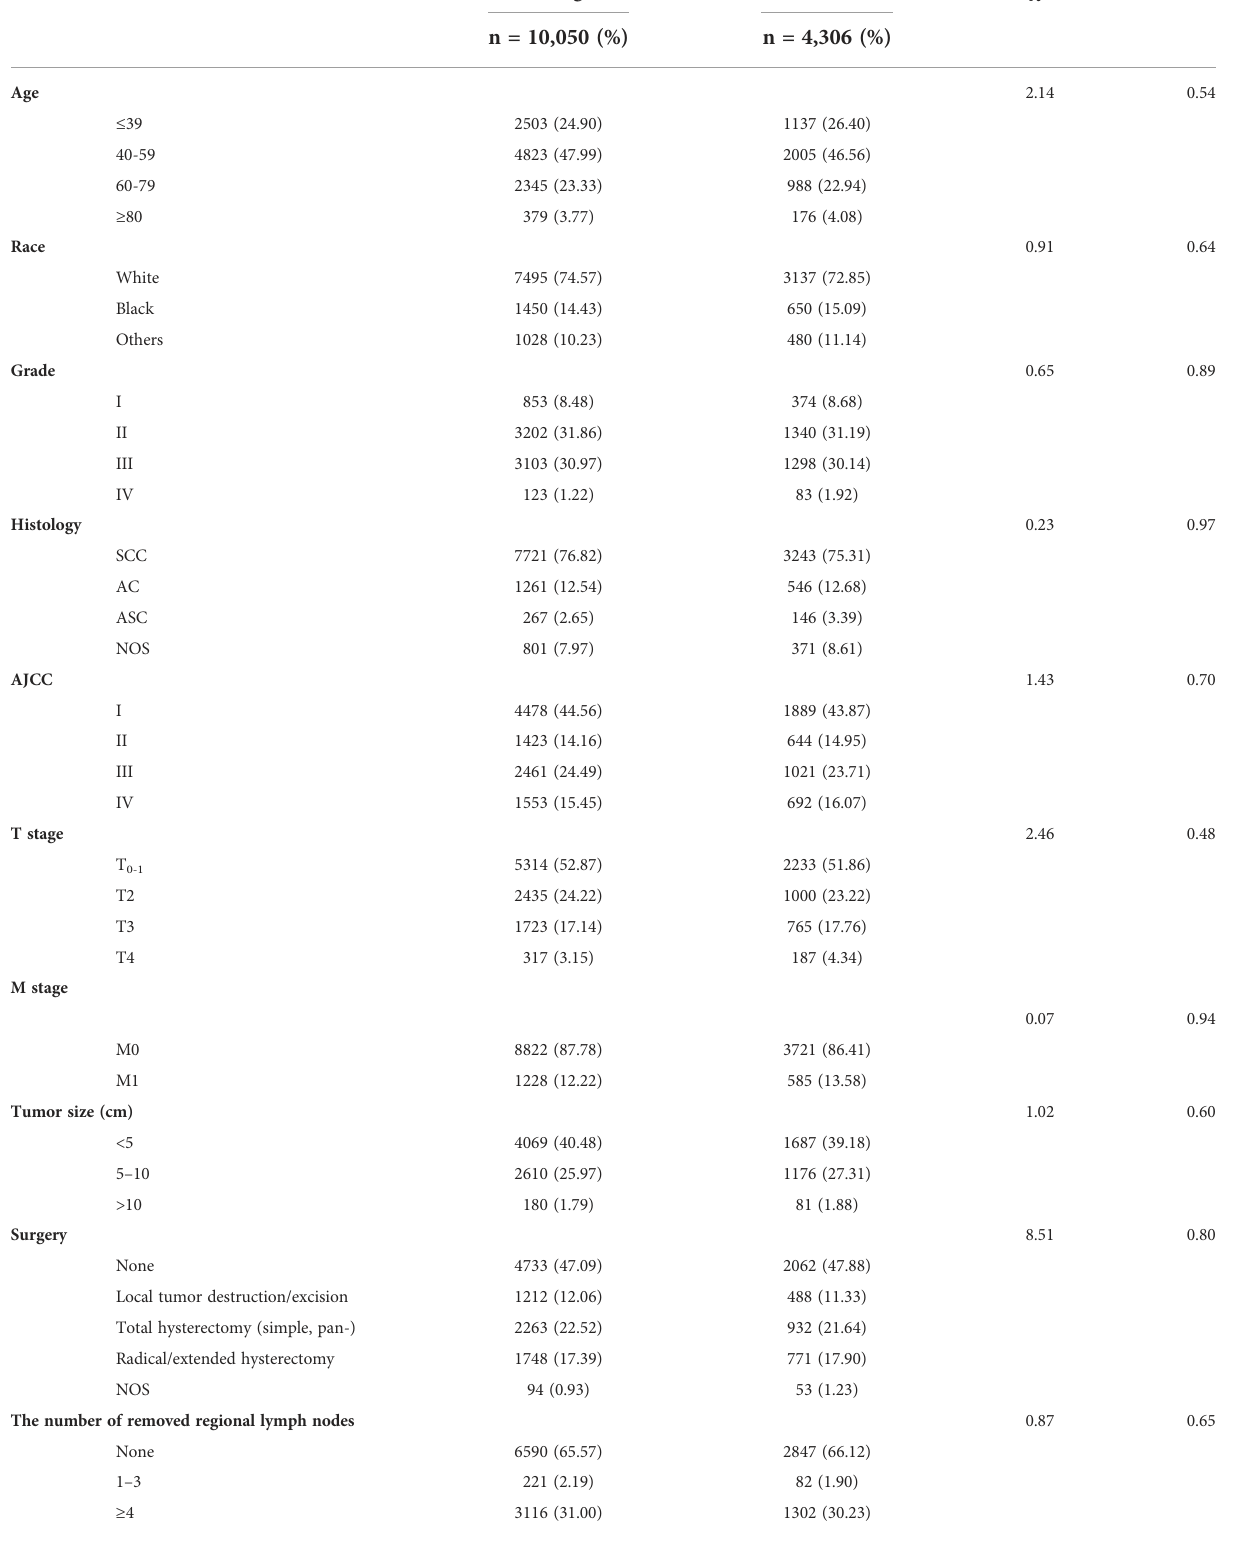
TABLE 1 Baseline characteristics of patients with cervical